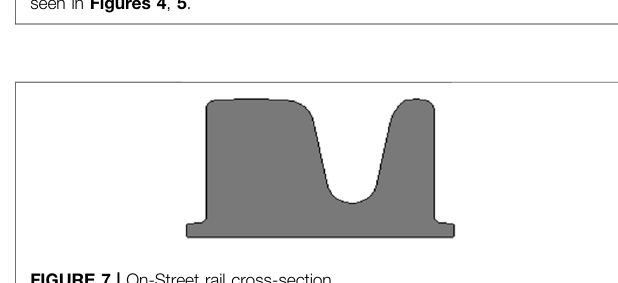
FIGURE 7 | On-Street rail cross-section.